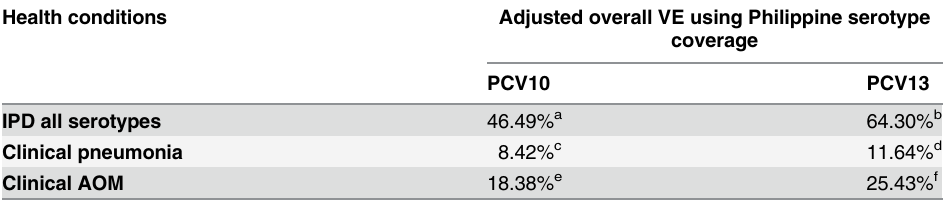
Table 2. Vaccine efficacy by syndrome adjusted by 2+1 schedule and local serotype